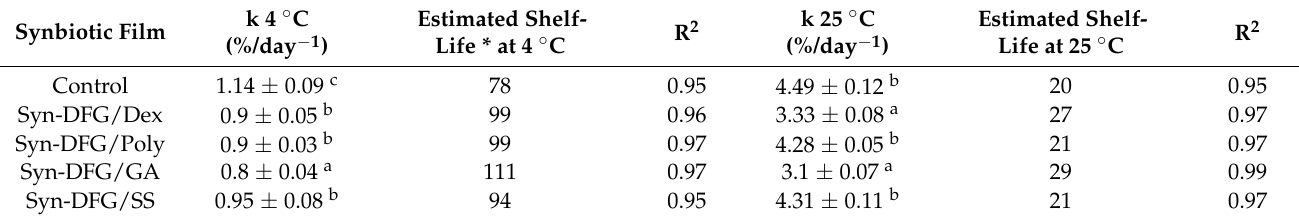
Table 3. Inactivation rates of L. casei immobilized in plasticized synbiotic DFG and stored either in chilled or room- temperature